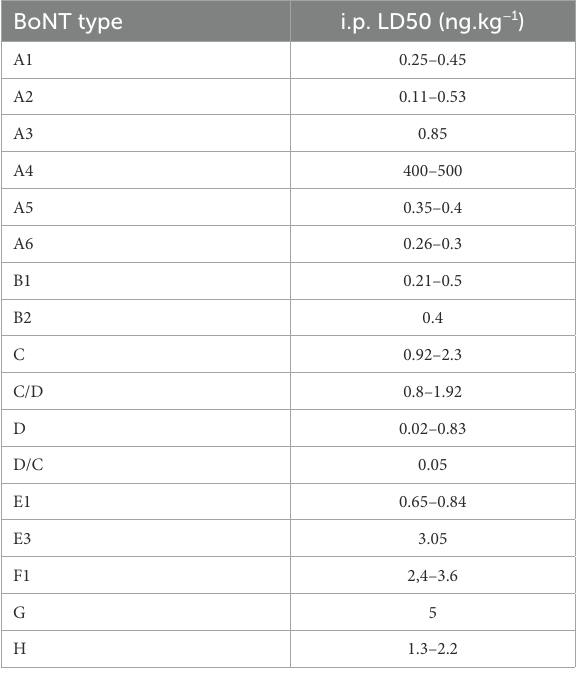
TABLE 3 Lethal dose 50 of the different types of BoNT in mice. BoNT